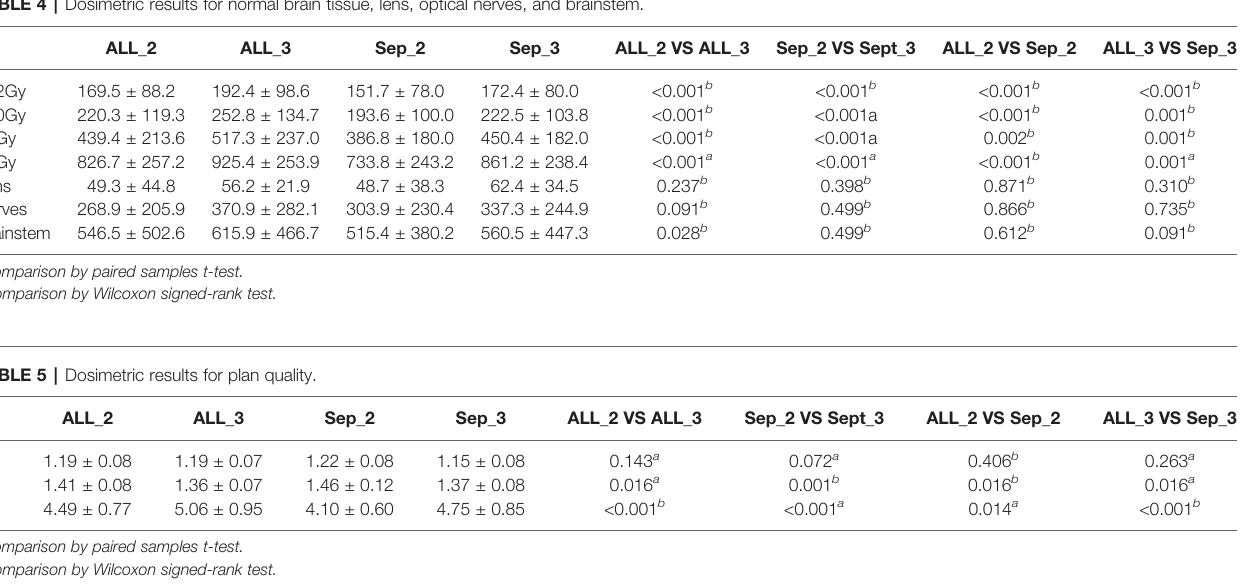
TABLE 4 | Dosimetric results for normal brain tissue, lens, optical nerves, and brainstem.